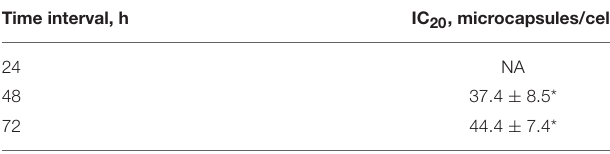
TABLE 1 | IC 20 values of QD-encoded